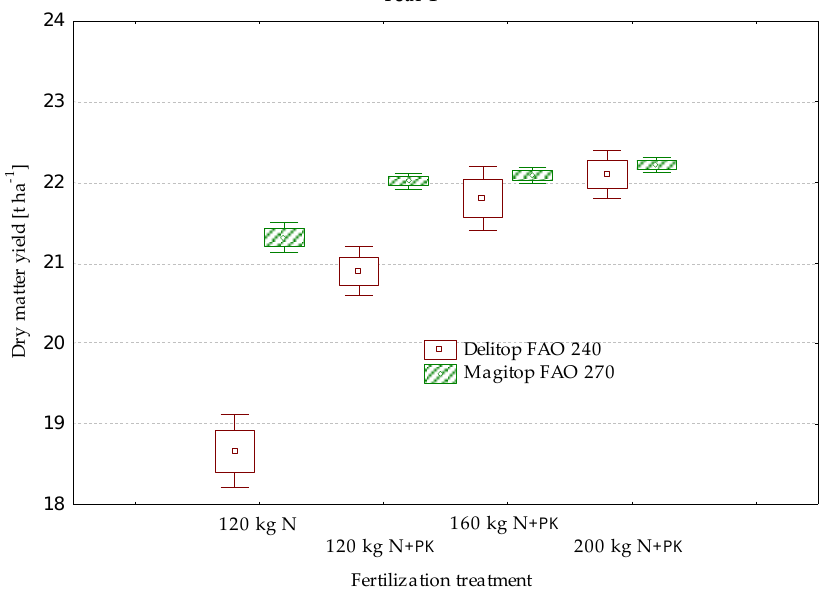
Figure 4. Boxplot of DMY of two maize varieties in the first year of study.